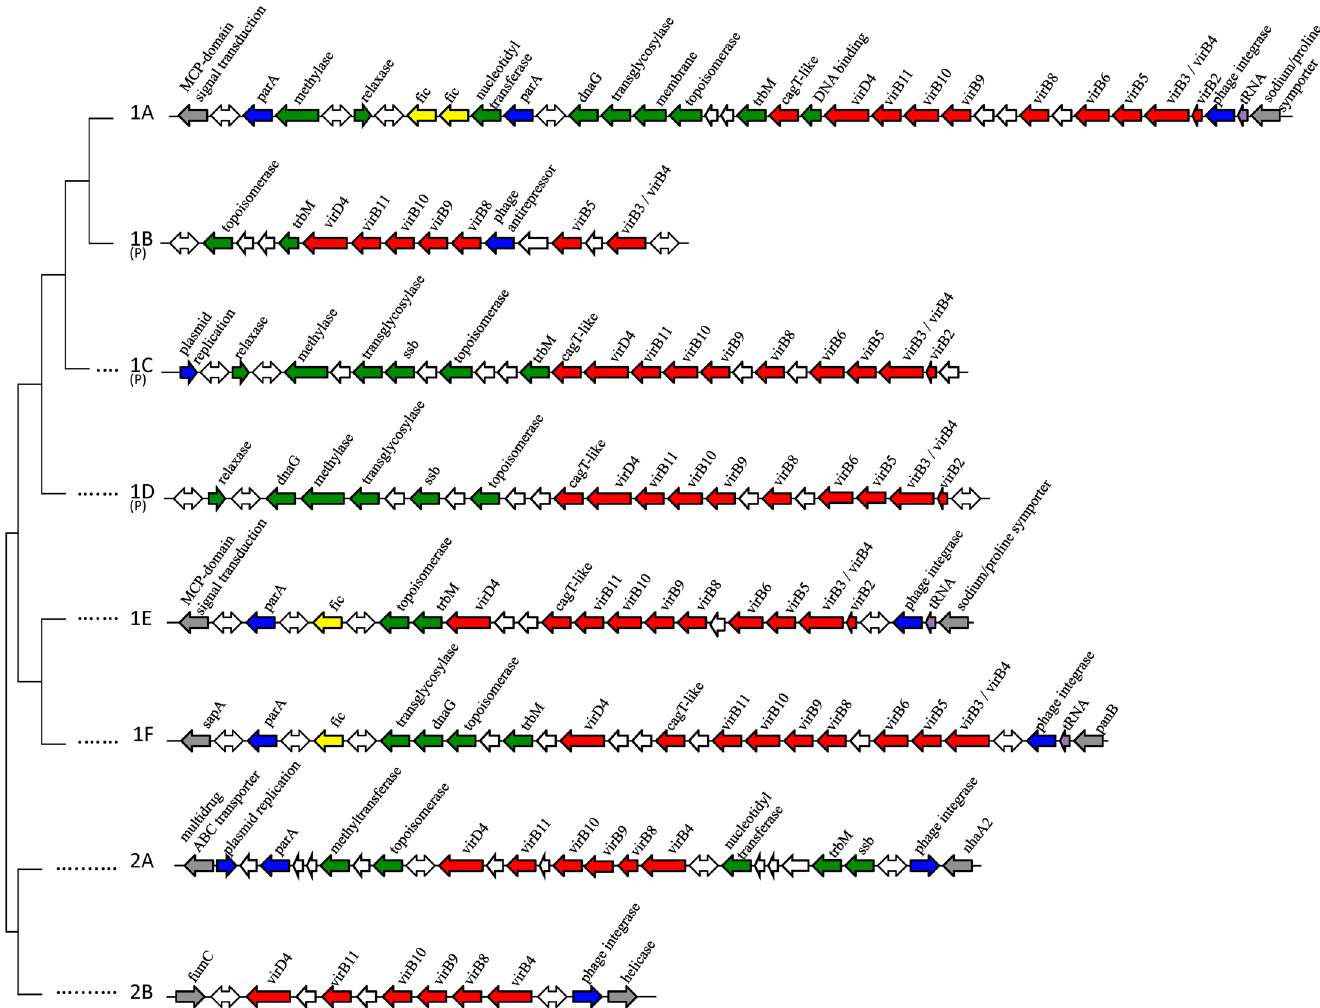
Fig 2. Schematic representation of T4SS regions in genomic islands and plasmids. The T4SS regions and their adjacent genes are listed according to the phylogenetic clustering as shown in Fig 1. The T4SS regions in genomic islands or plasmids (P) contain: vir / cag genes (red), phage integrases and other phage-related genes (blue), genes of plasmid origin (green), tRNA genes (purple), chromosomal integration sites (grey) and genes of unknown function (white). Double-sided arrows indicate genes of unknown function in varying orientations. The genomic islands of cluster 2 are in the chromosomes located in the opposite orientation as shown in Fig